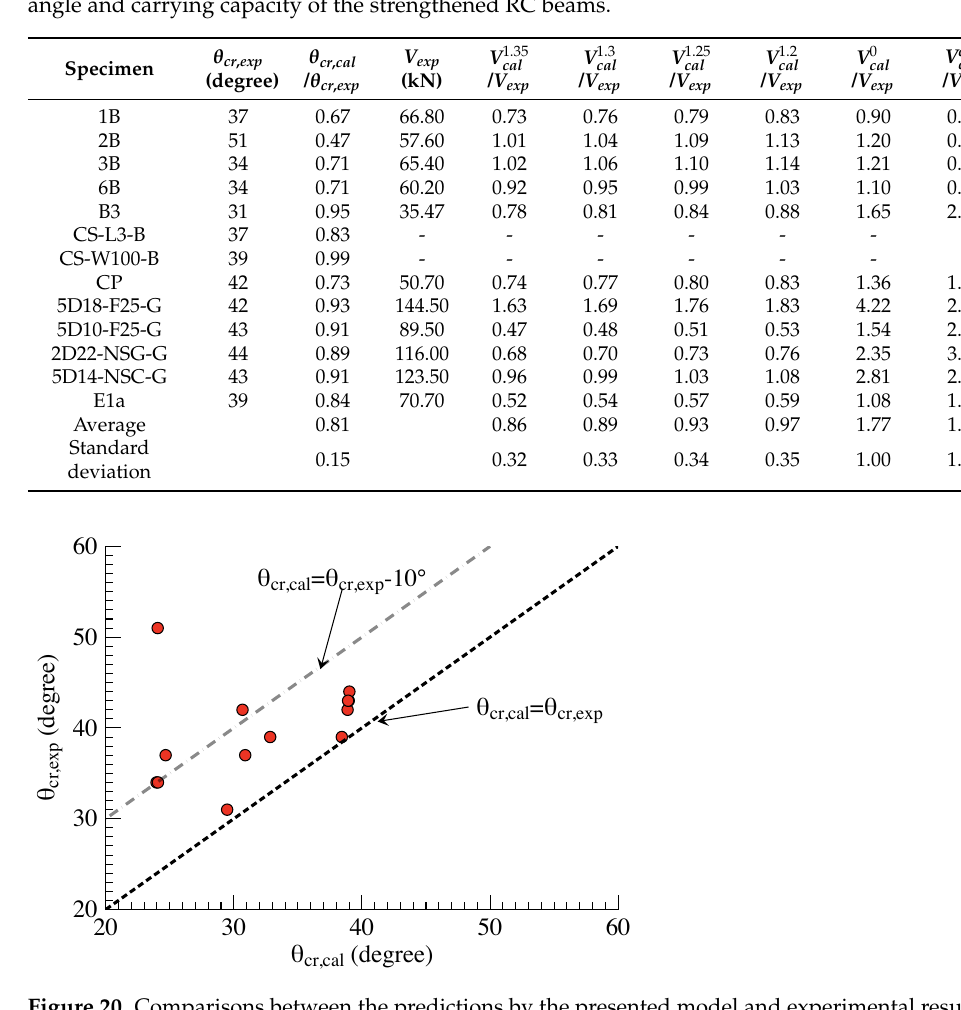
Figure 20. Comparisons between the predictions by the presented model and experimental results of cracking